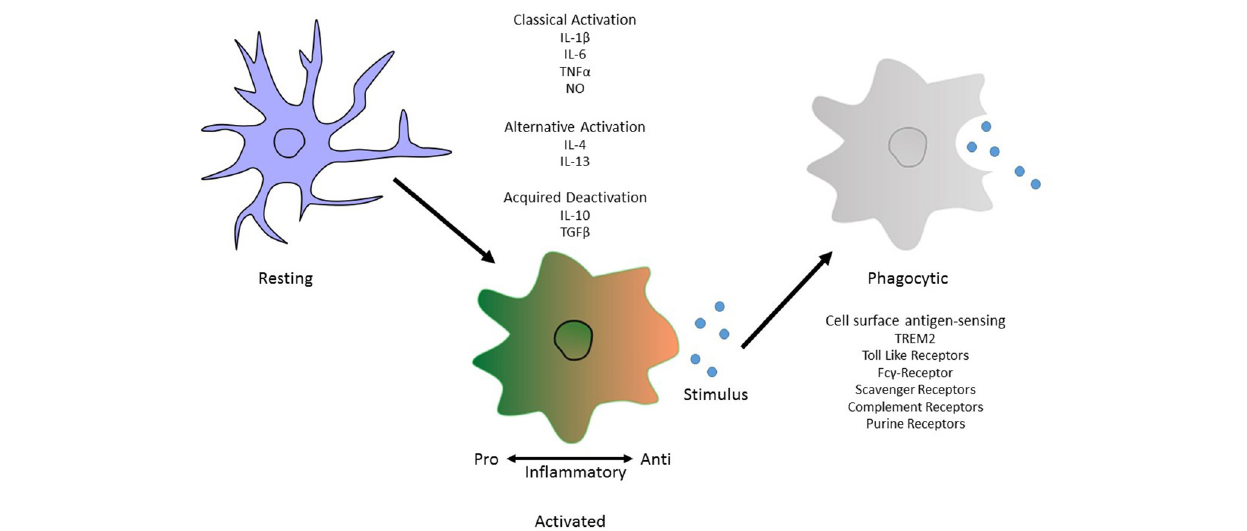
FIGURE 1 | Morphological phenotype of Microglia. An illustration depicting the different phenotypic states. These are “classical activation,” “alternative activation,” and “acquired deactivation.” Classical activation, otherwise considered to be the M1 phenotype and so is pro-inflammatory, is stimulated by IFN- γ and is associated with the production of cytokines such as TNF- α and IL-1 β . Subsequently the alternative activation, or M2 phenotype, defined by the release of anti-inflammatory cytokines IL-4 and IL-13. The third activation phenotype, acquired deactivation, is thought to be a subtype of the M2 phenotype, releases IL-10 and TGF- β . Activation does not inclusively mean a phagocytic phenotype in microglia. For this to occur, antigen sensing receptors are made available on the cell surface to allow pathogen recognition. In Alzheimer’s disease, the best known of these is TREM2 but others include Toll-like receptors and members of the complement